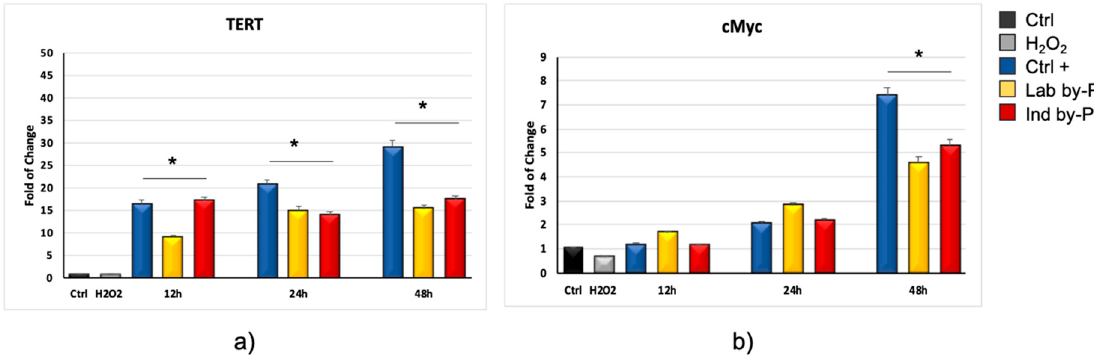
Figure 2. Expression of specific markers of senescence TERT and c-Myc. The expression of TERT ( a ), and c-Myc ( b ) was evaluated in H 2 O 2 -senescent hADSCs exposed for 12, 24, or 48 h to ascorbic acid (CTRL+, blue bars) or to Lab by-P (yellow bars) or Ind by-P (red bars). Grey bars represent the hADSCs exposed to H 2 O 2 , without pre-treatment with the extracts. The mRNA levels for each gene were expressed as fold of change (2 −∆∆ Ct ) of mRNA levels observed in untreated hADSCs (CTRL-, black bar) defined as 1 (mean ± SD; n = 6) and normalized to hypoxanthine phosphoribosyltransferase 1 (HPRT1). Data are represented as mean ± SD referring to the control (* p ≤ 0.05).